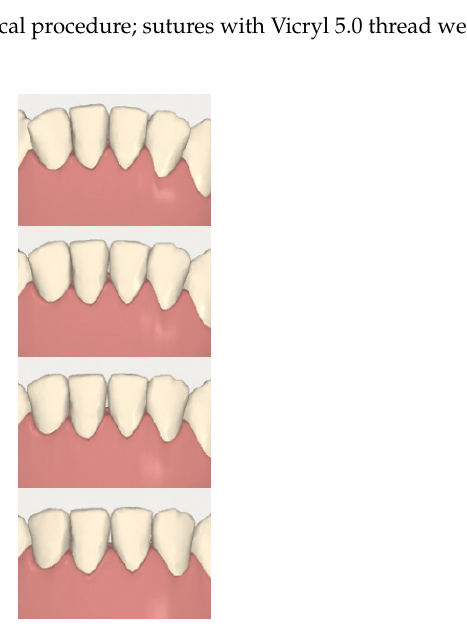
Figure 10. Case 1: digital sequential (up to down) detail of the difficult radicular movement of 3-2 and 4-2.